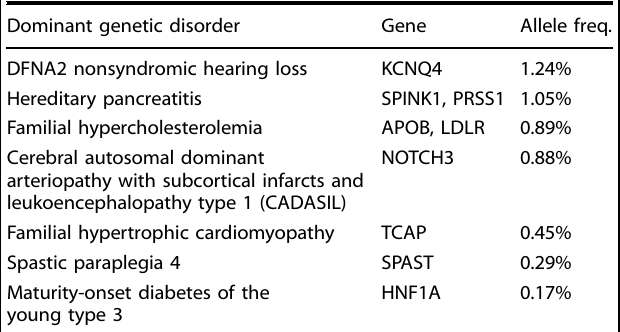
Table 3. Autosomal dominant disorders with the highest allele frequencies in the cohort.